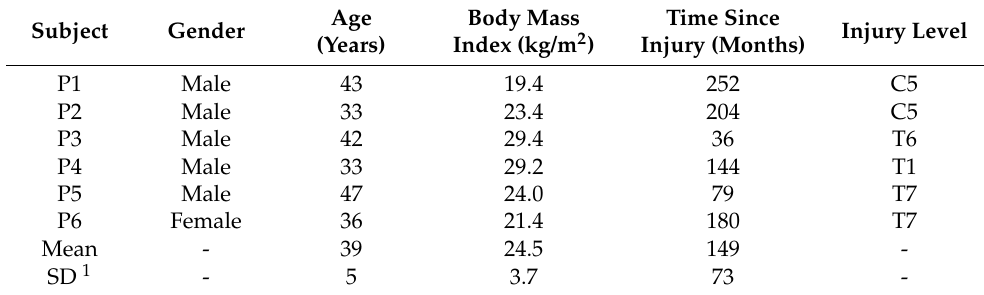
Table 1. Participants’ specific inclusion